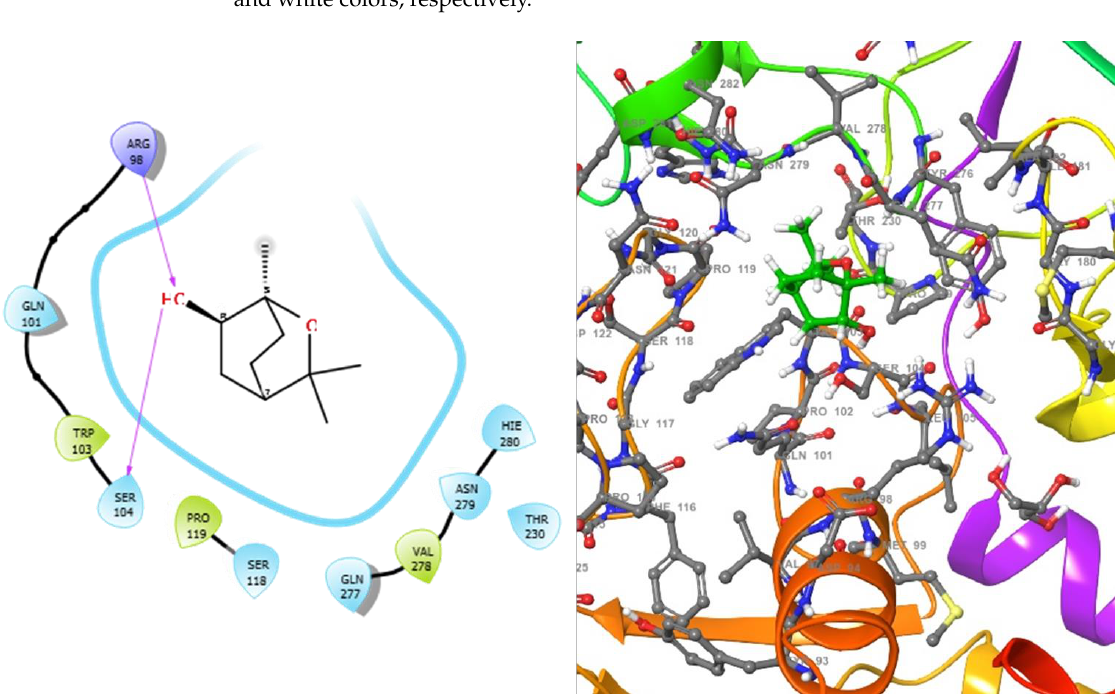
Figure 4. 2D ( left ) and 3D ( right ) views of the molecular interactions at the surface of the active site of DNA gyrase subunit A N-terminal domain binding with 1,3,3-trimethyl-2-oxabicyclo[2.2.2]octan-6-ol (the green stick model). The negative, positive, and neutral charges of the binding site residues are represented with red, blue, and white colors, respectively.